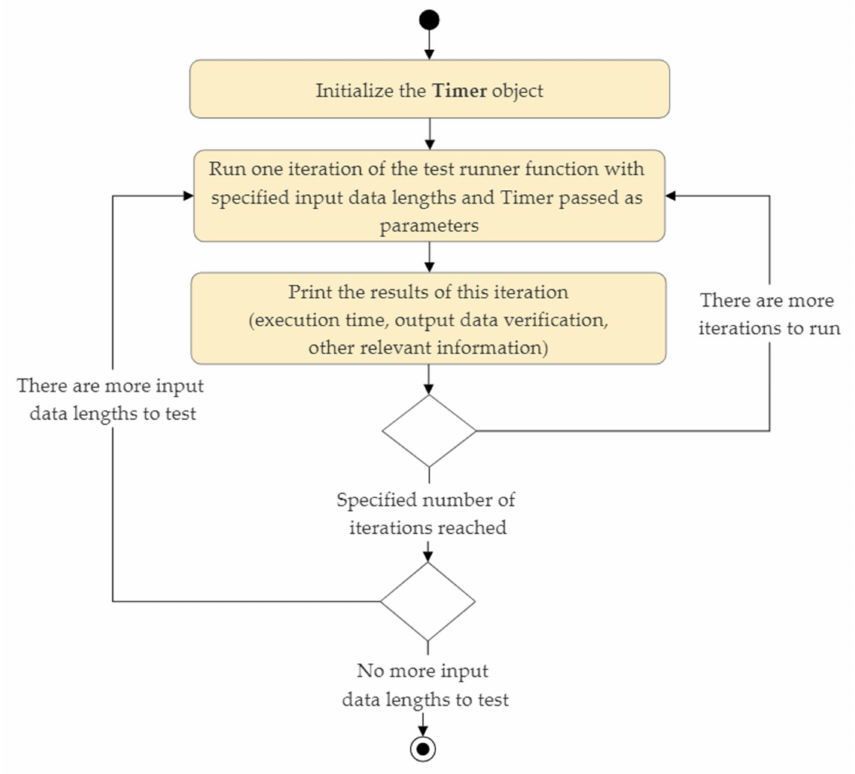
Figure 2. The general algorithm of the execution time